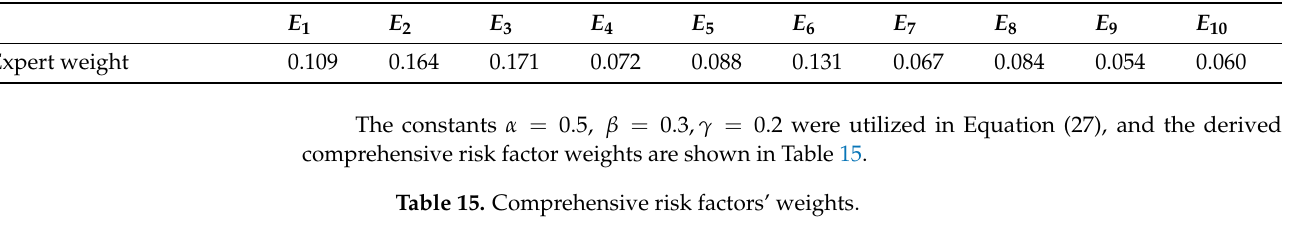
Table 10. Each expert’s relative degree of agreement is shown in Table 14. Table 14. Experts’ relative degree of agreement for the risk factors weights’ calculation.